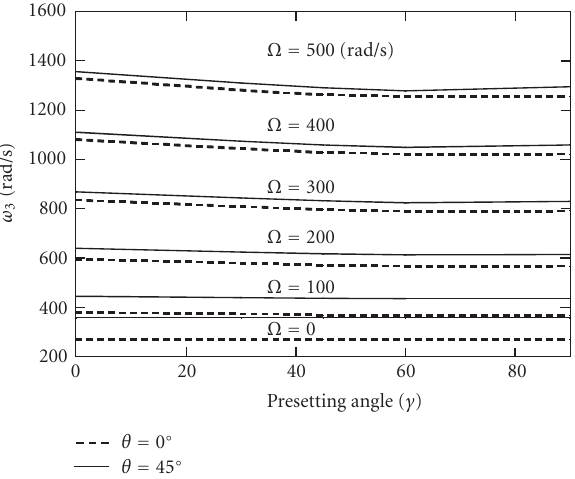
Figure 12: Variation of the third coupled frequency versus preset- ting angle for selected rotational speeds and two di ff erent ply angles ( β 0 =